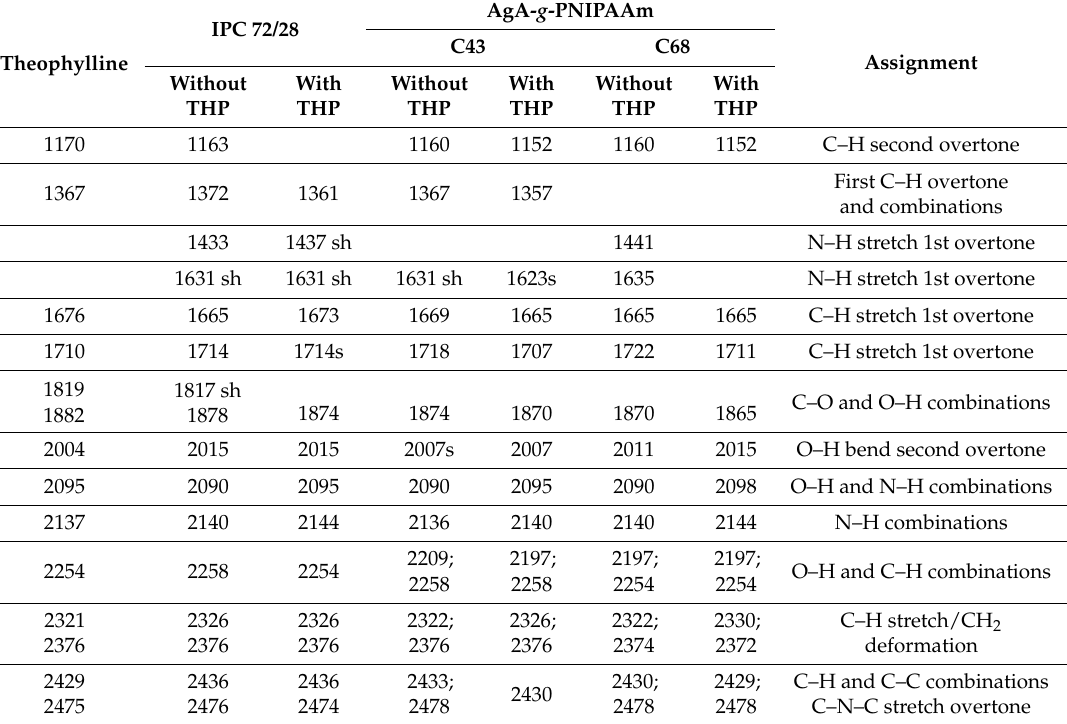
Table 2. NIR characteristic bands and their assignments for the samples studied.